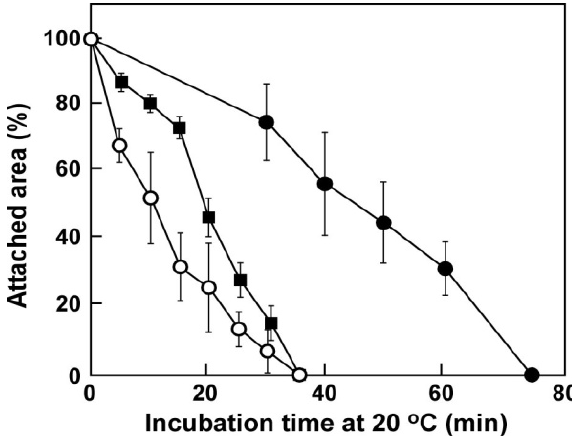
Figure 5. The average attached areas of BAEC sheets harvested from PIPAAm gel modified tissue culture polystyrene surface (close squares), PIPAAm grafted porous membrane (PM) (close circles) and poly( N -isopropylacrylamide- co -ethylene glycol) grafted PM (open circles) at 20